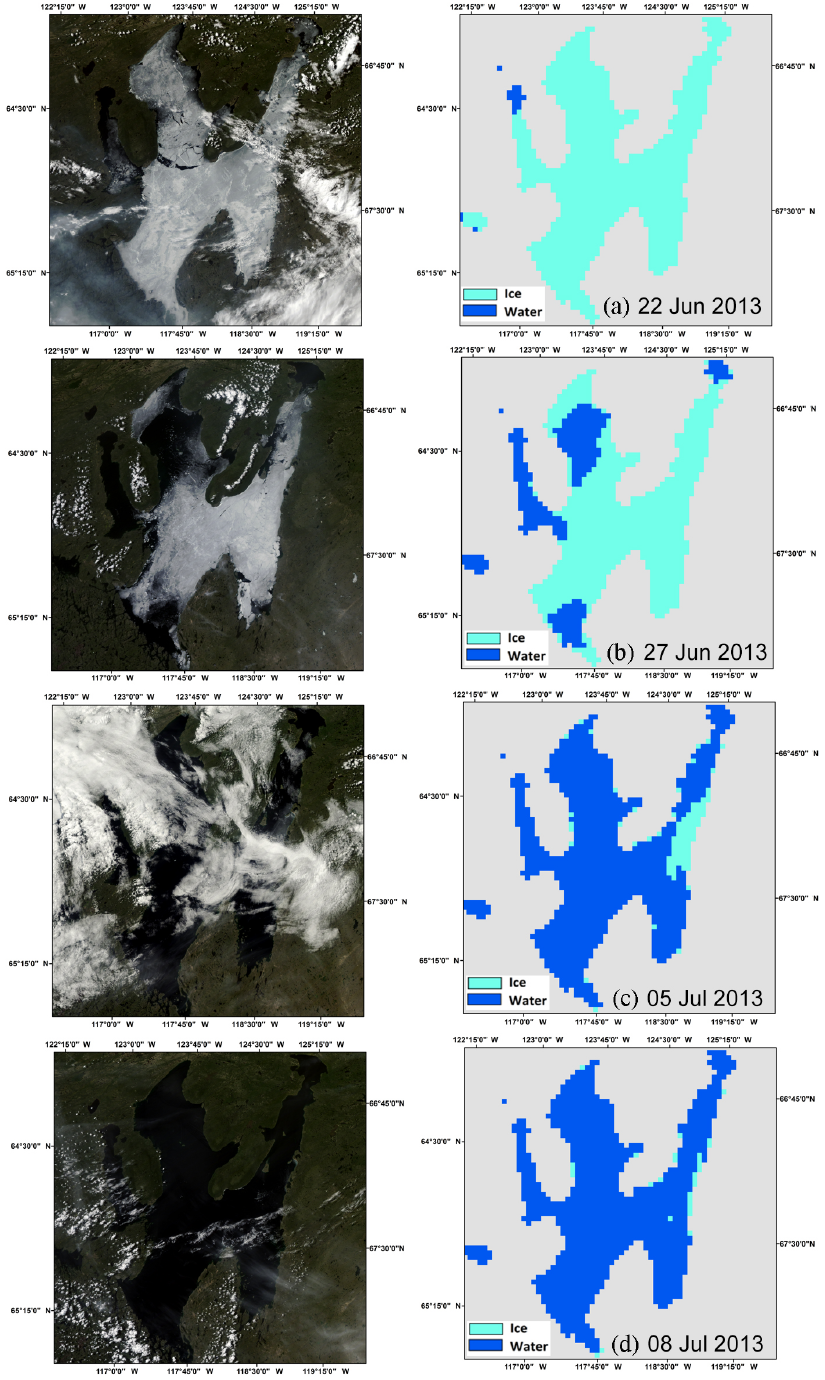
Figure 3. Comparisons between MODIS quick-look images (left column) and AMSR-E/2 LIP results (right column) for Great Bear Lake (GBL) on 22 June (a) , 27 June (b) , 5 July (c) , and 8 July 2013 (d) . The images are in the EASE-GRID version 2 polar projection format, consistent with the underlying AMSR-E/2 gridded T b dataset used for the LIP